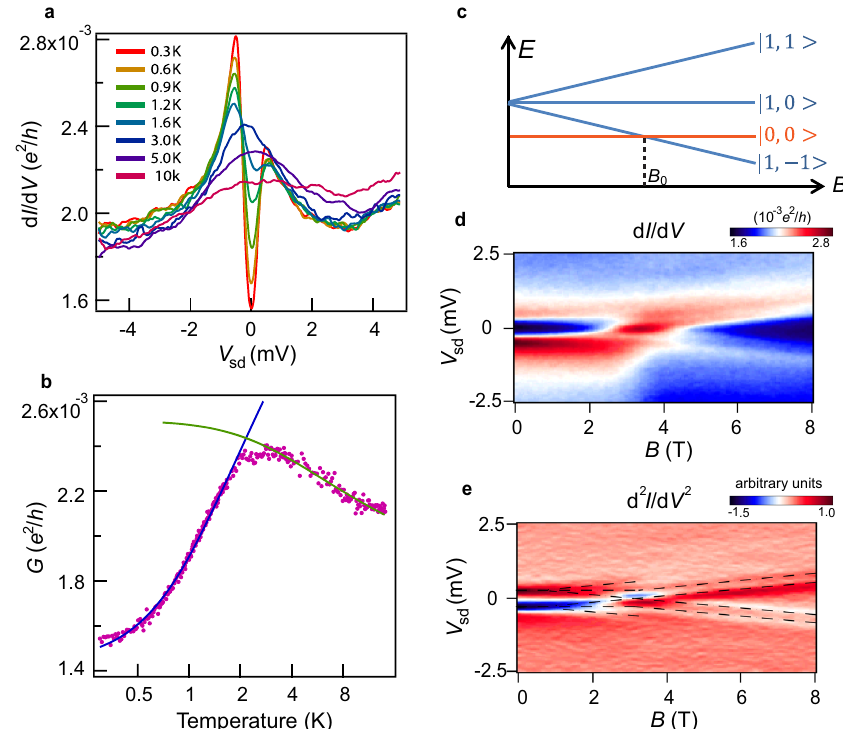
Fig. 2 Two-stage Kondo effect. a Plot of differential conductance d I /d V against V sd at V g = − 2 V (region II) of device 1 at various temperatures. b Temperature dependence of the zero-bias conductance G ( T ) at V g = − 2 V. The green and blue lines are fi tting results to spin-1/2 fully screened Kondo model (Supplementary Eq. (1)) and inverted spin-1/2 Kondo model (Eq. (1)), respectively. c , d Differential conductance d I /d V as a function of B and V sd at V g = − 2 V and temperature T = 280 mK ( d ). Energy level sketch of magnet induced singlet to triplet transition process ( c ). B 0 = 3.2 T is the critical point where the transition occurs. e Numerical derivative of d I /d V in d . The black dash line indicates the peak position, which corresponds to the transition lines between spin singlet and